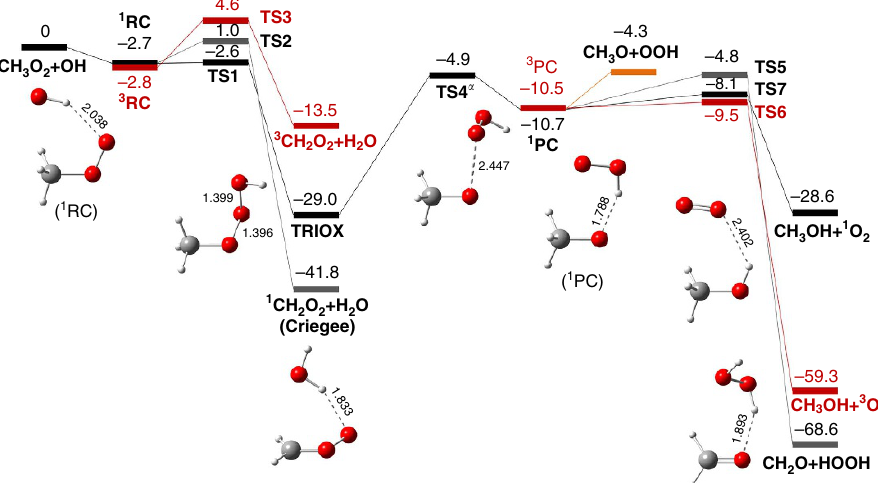
Figure 1 | Potential energy surface for CH 3 OO þ OH biradical reactions. Coupled-cluster energies (kcalmol (cid:4) 1 ) relative to separated reactants CH 3 O 2 and OH, based on DFT geometries (CCSD(T)-F12/cc-pVTZ-F12//M06-2X-D3/6-311 þþ G(3df,3pd) level of theory). TS, transition state; RC, reactant complex; PC, product complex. The singlet reaction pathways are depicted in black and grey, while the triplet reaction pathways are depicted in red for clarity. a TS4 was optimized at M06-D3/6-311 þþ G(3df,3pd) level of theory, see text (each structure with formula or acronym is depicted separately in Supplementary Fig.